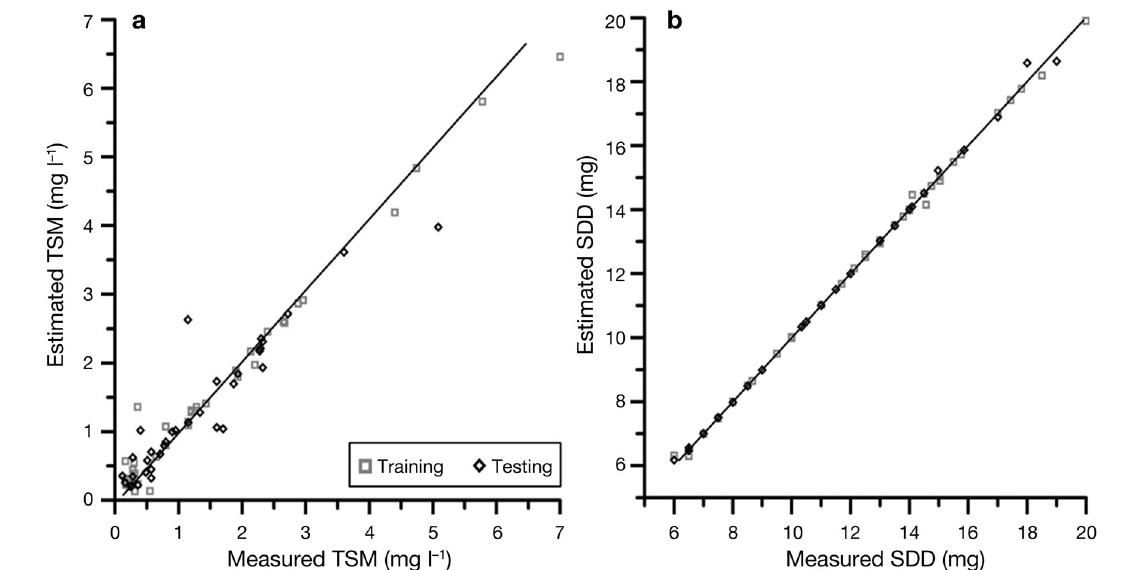
Fig. 3. (a) Total suspended matter (TSM) and (b) Secchi disk depth (SDD) estimated from MERIS versus field measurements. In both cases, 73 data points were used. Training and testing datasets are shown in different symbols. Average estimated and average measured TSM was 1.45 and 1.44 mg l −1 , respectively, with a coefficient of determination (R 2 ) of 0.951. Average and measured SDD were both 11.64 m (R 2 =